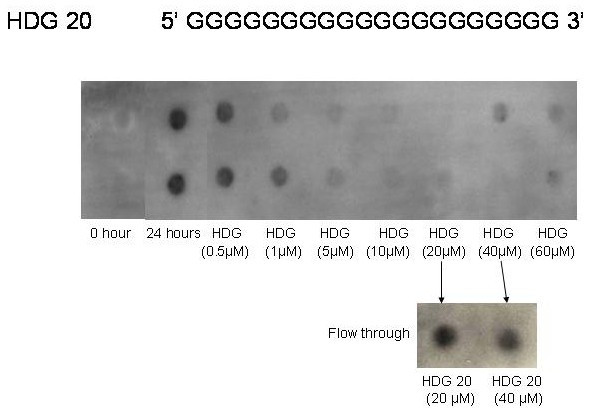
HDG 20 inhibits aggregation of mutant Htt fragment. HDG 20, a 20-base monotonic G oligonucleotides was tested in the assay outlined in Figure 1 (see legend) at the indicated concentration. The reaction was carried out 4 times in duplicate for 24 hours and a representative blot from the four independent experiments is shown. 0 hour, reaction mixture stopped at time zero; 24 hours, control reaction lacking oligonucleotides. (Inset), The Flow-through from filter binding reaction containing HDG 20 (20 μM or 40 μM) was placed on blotting paper, dried and processed as described in the legend to Figure 1.